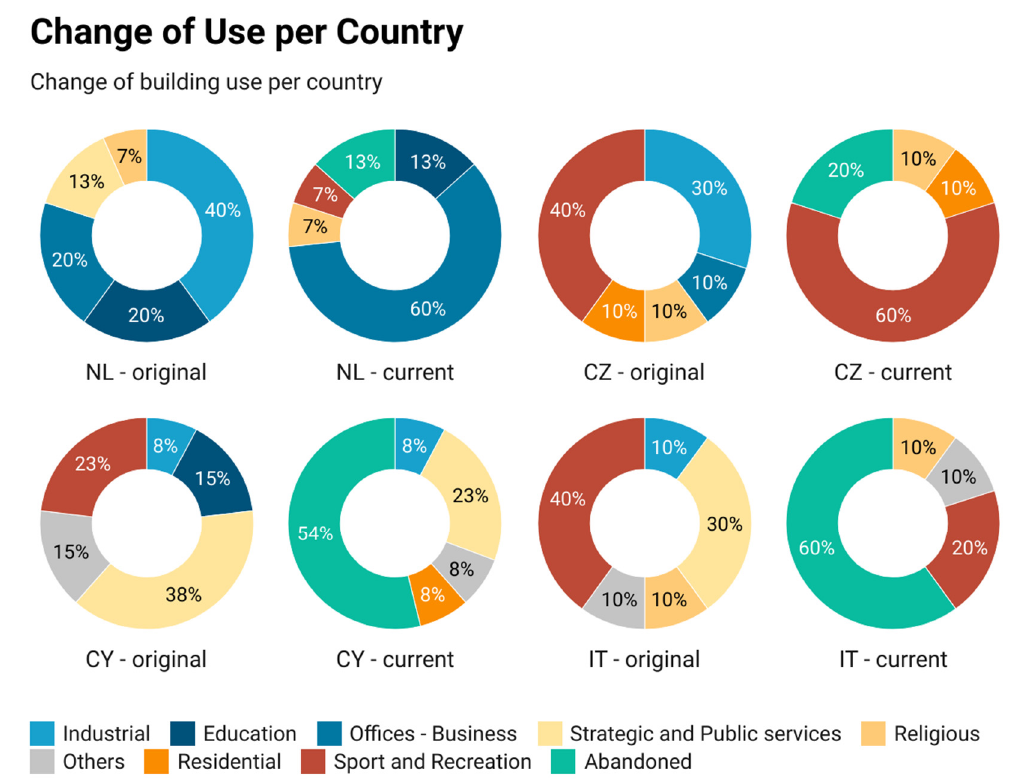
Figure 7. Change of building use per country.